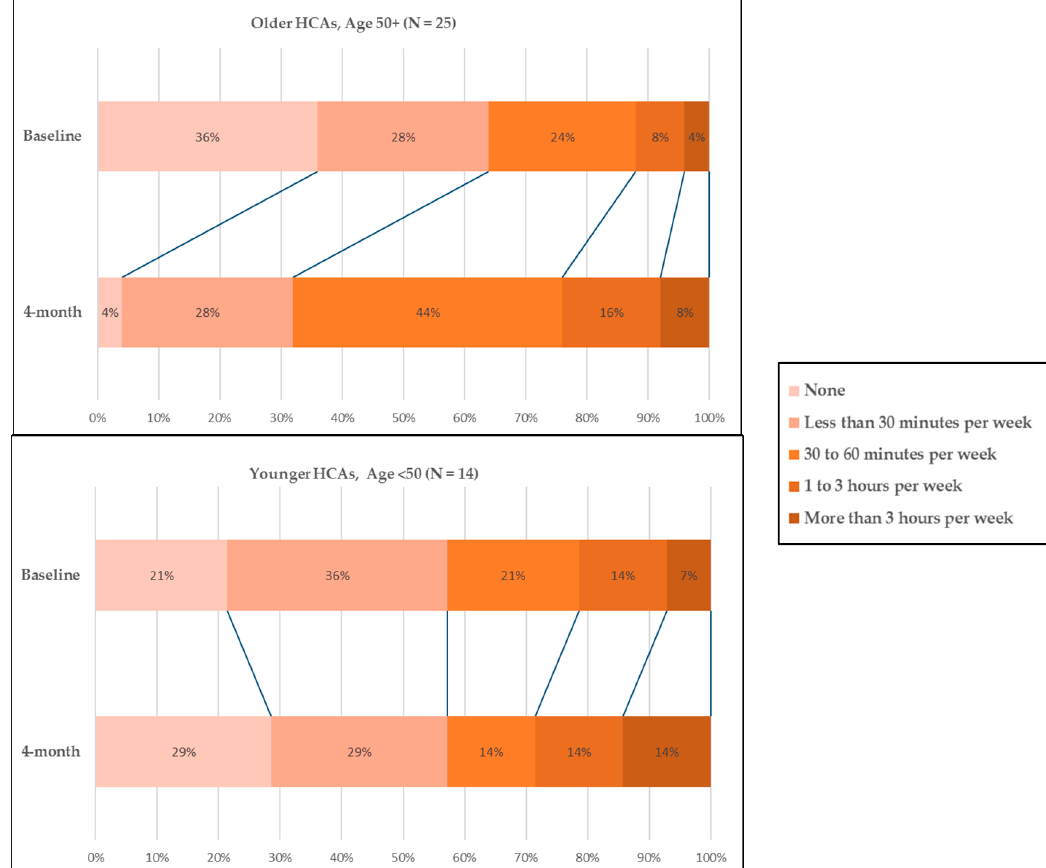
Figure 1. Home care aides’ stretching or strengthening time spent in the last week.